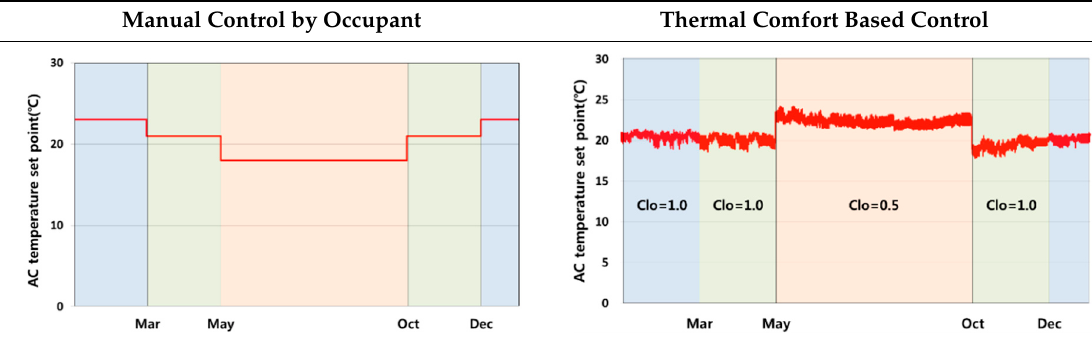
Table 2. Annual changes in the indoor set temperature by each control method.